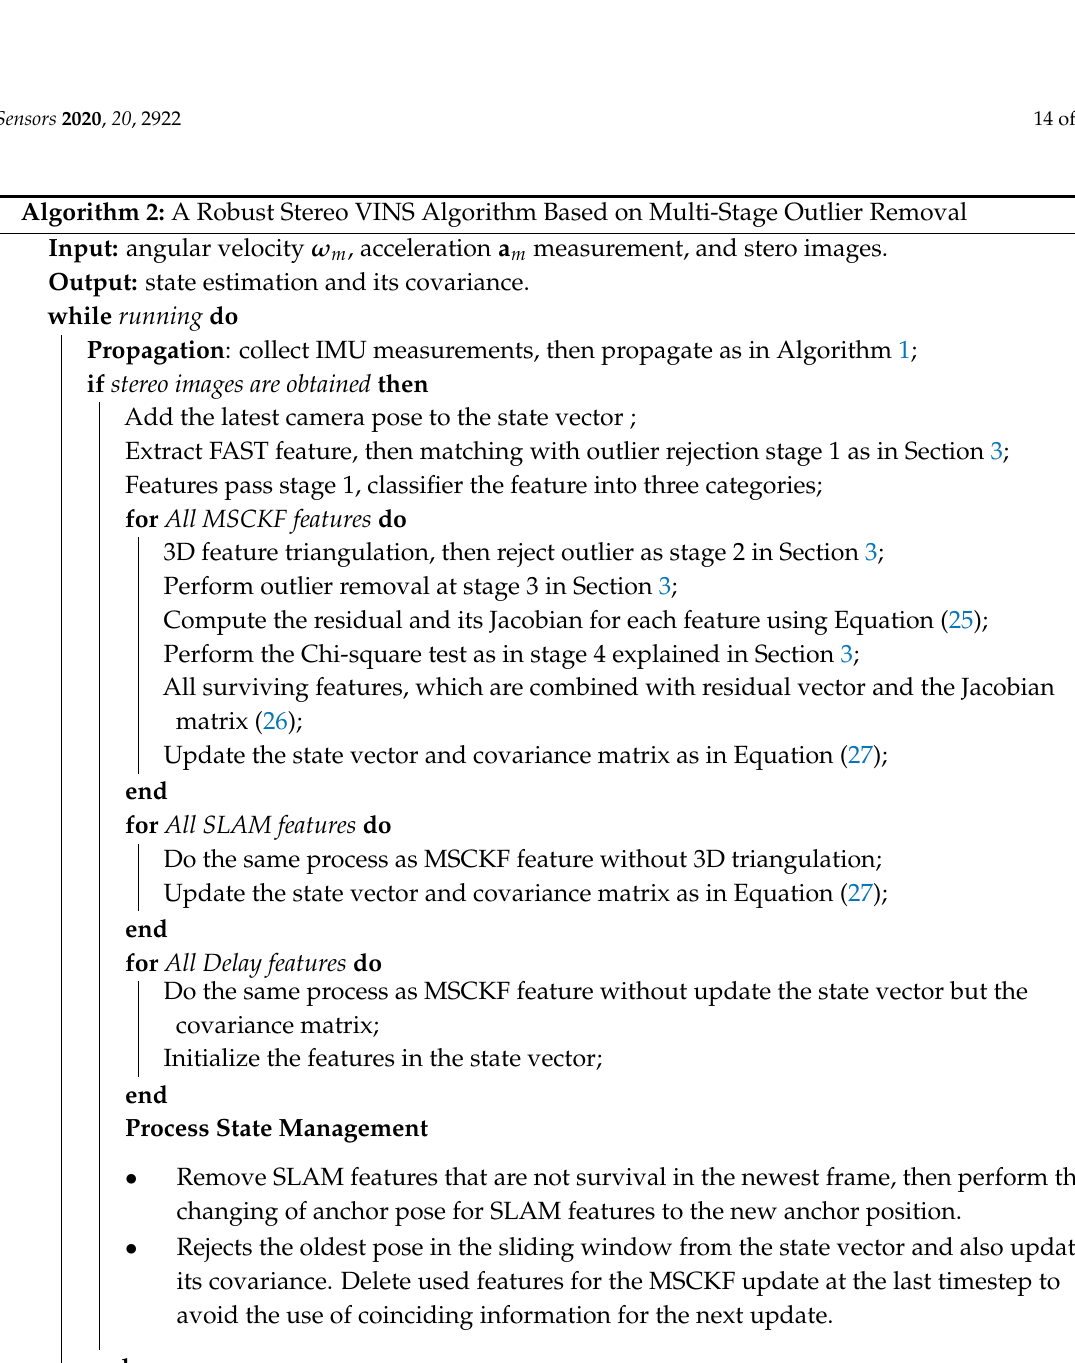
Algorithm 2: A Robust Stereo VINS Algorithm Based on Multi-Stage Outlier